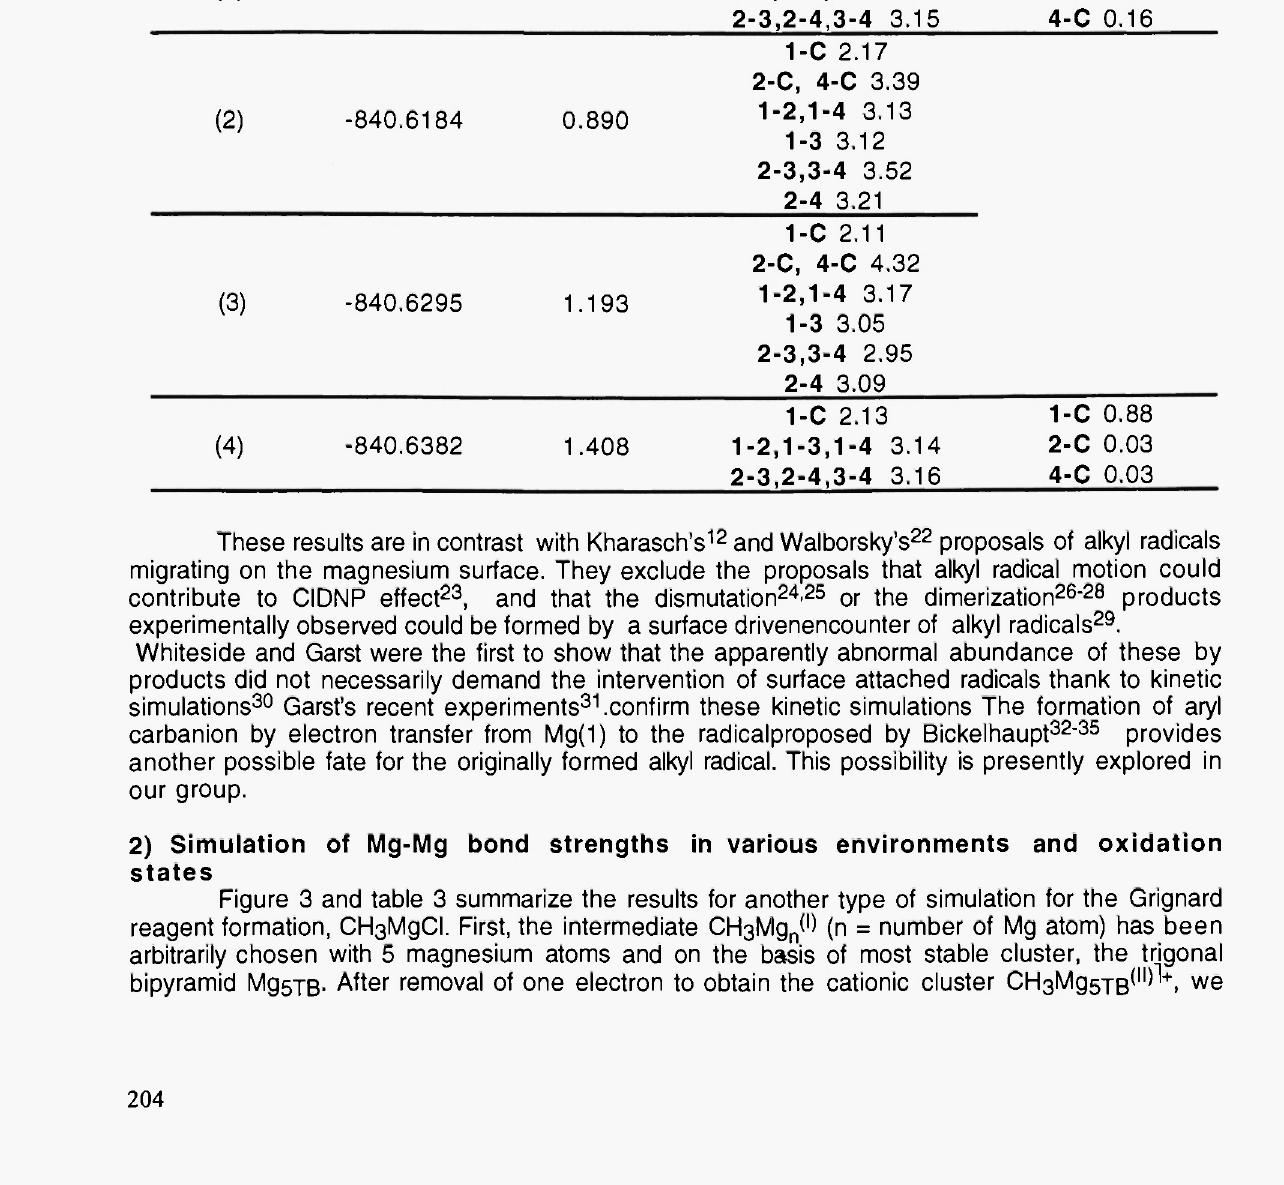
Table 2 : Energies, interatomic lengths and bond orders in function of the methyl group shift in the CH3Mg4T cluster CH3Mg4T Total energy Dissociation Interatomic Bond orders